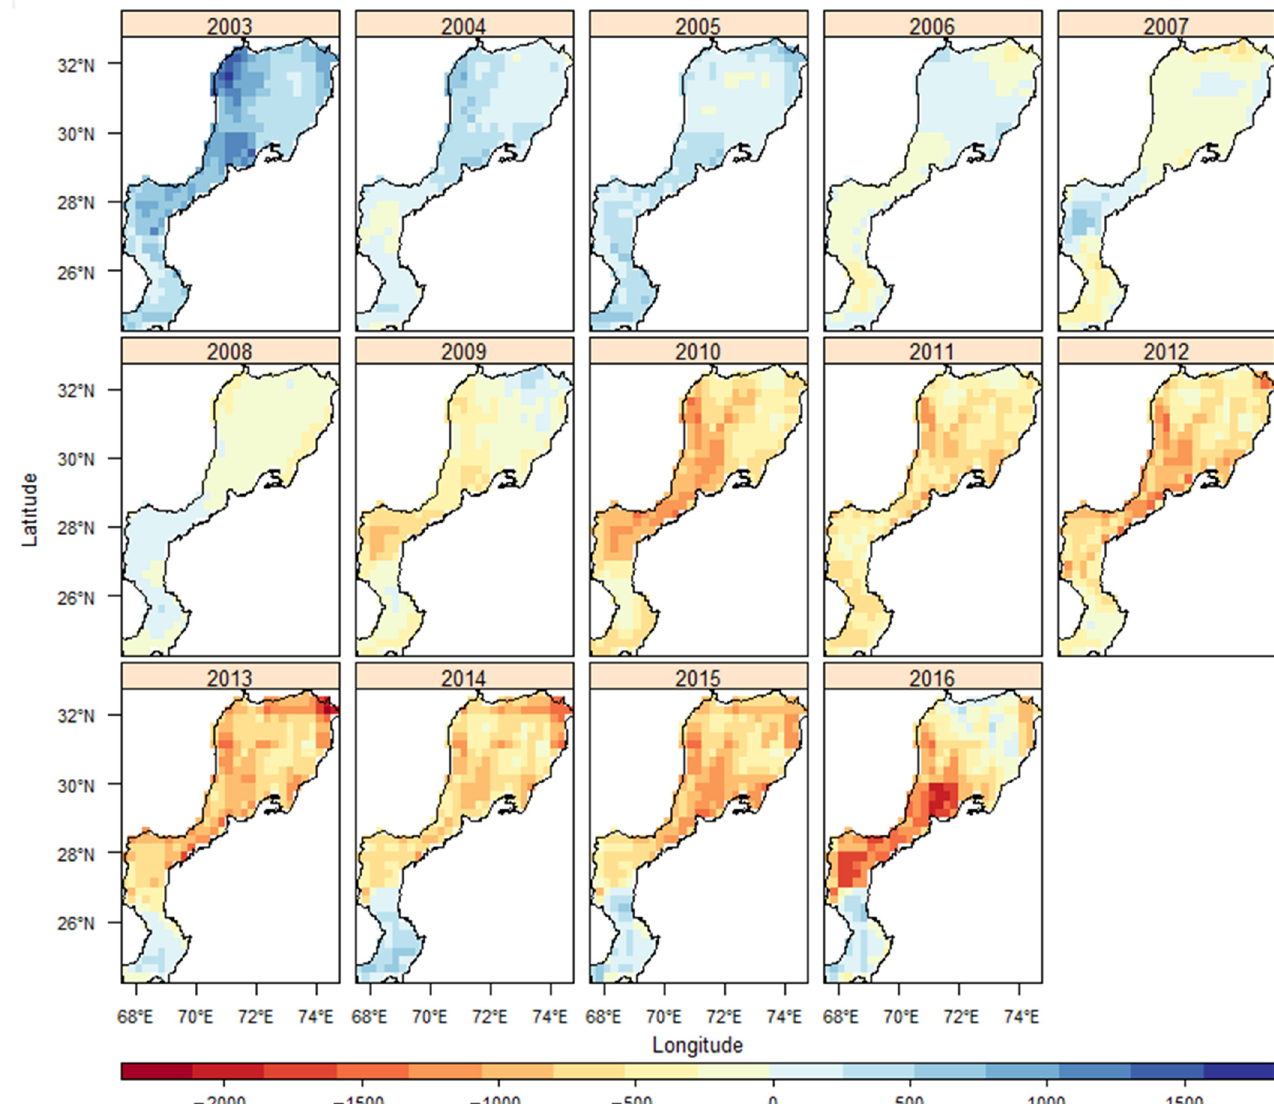
Figure 12. Spatial distribution of GWS (mm) on a yearly basis.